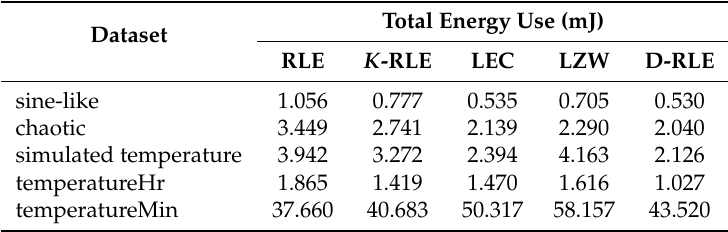
Table 6. Total energy use for the datasets with different sizes.